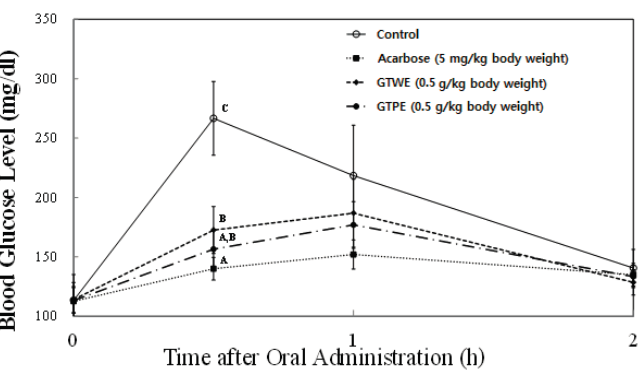
potency of tea and tea pomace extracts to significantly reduce plasma glucose excursion in response to diets high in sucrose.